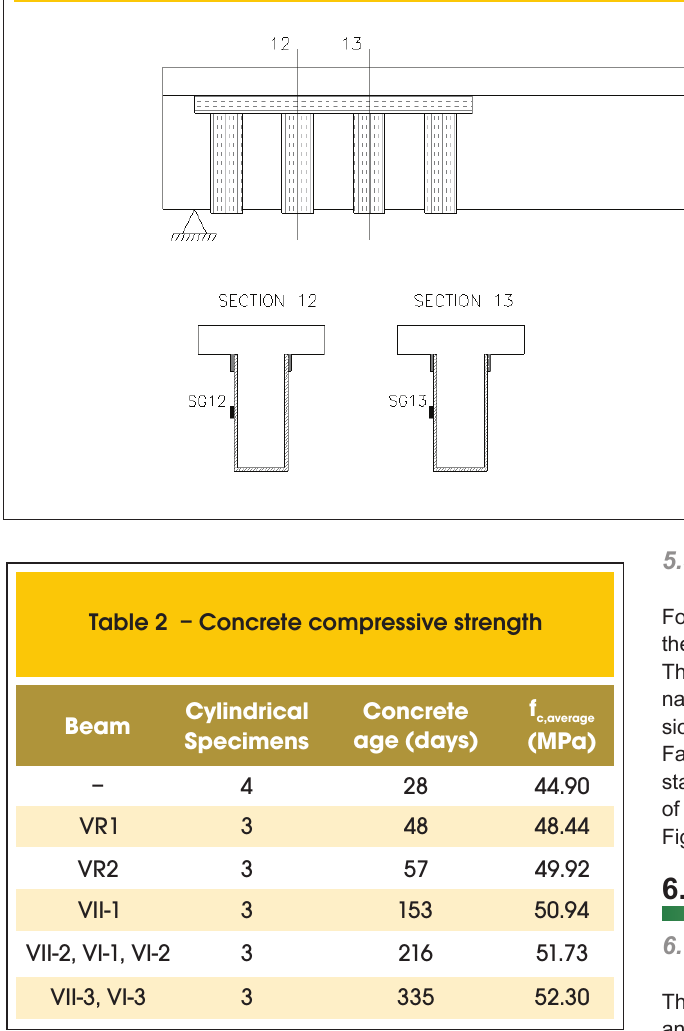
Figure 10 – General view of strain gauge locations on CFC U stirrups of all strengthened beam, distance from support: section 12 = 0.33 cm; section 13 = 0.55 cm; the other sections are symmetric